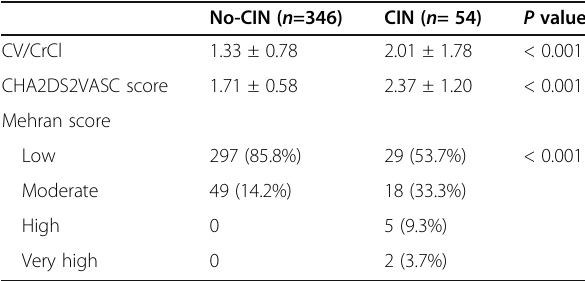
Table 3 CV/CrCl, CHA2DS2VASC score, and Mehran